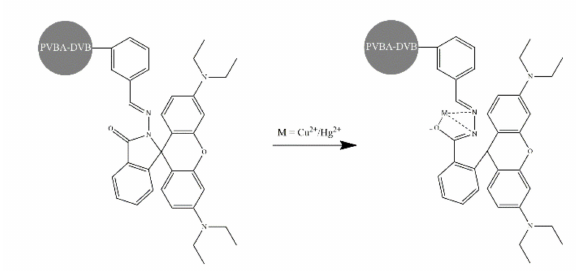
Figure 52. The proposed sensing mechanism of RHB (Table 4, No. 3) to Cu 2+ and Hg 2+ [108]. Sensor No. 4, 5, and 6 (Table 4) were developed for the co-detection of Al 3+ and Hg 2+ . Among these, sensor No. 4 was a chromenone-based rhodamine, synthesized by Mondal S., et al. [109], and was used for fluorometric and colorimetric recognition of Al 3+ and Hg 2+ in CH 3 CN:H 2 O (3:1, v / v , 10 mM HEPES buffer, pH = 6.85). In addition, the recognition of Al 3+ and Hg 2+ was discriminated by adding the tetrabutylammonium iodide salts. In the presence of I − , the color change was completely discharged, induced by Hg 2+ , and color was retained by Al 3+ (Figure 53). Sensor TR (Table 4, No.5), was a rhodamine-based sensor appended with triphenylamine and developed for Al 3+ and Hg 2+ detection with different sensing mechanisms (Figure 54) [110]. Furthermore, TR-coated test papers were successively prepared for the rapid detection of Al 3+ and Hg 2+